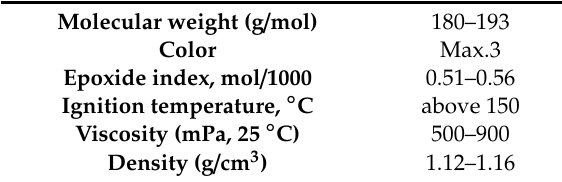
Table 3. Properties of used epoxy resin.